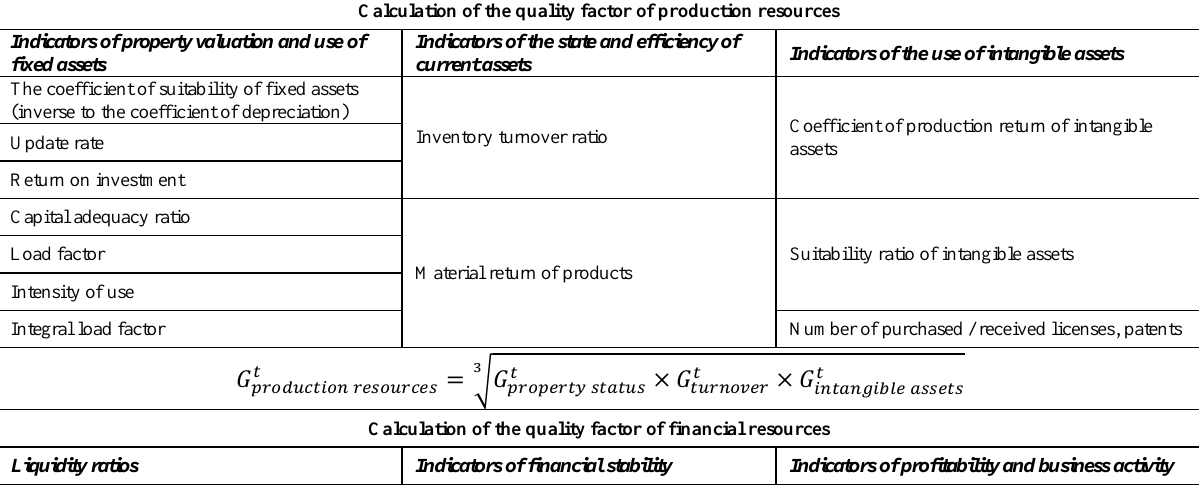
Table 4. System of indicators for assessing the quality of enterprise resources for diagnosing the risk sustainability of the investment